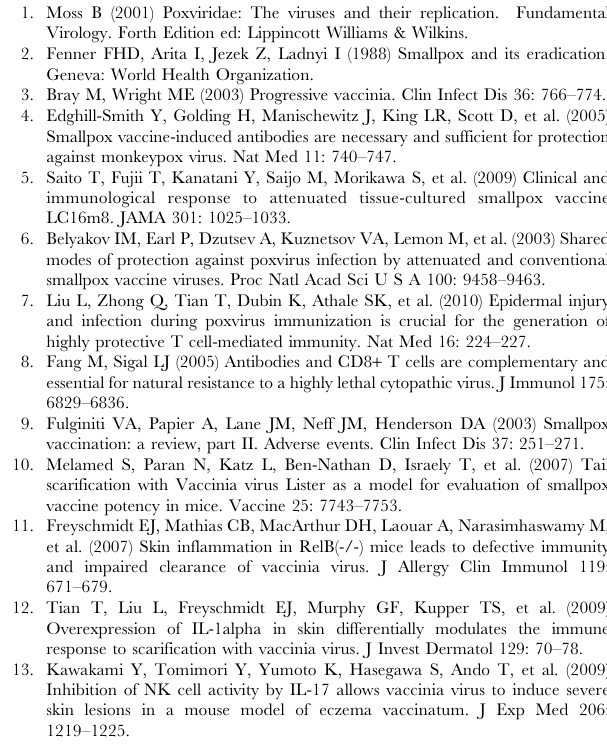
Figure S2 Lesion kinetic in Rag1 2 / 2 animals passively transferred with WT T cells. Rag1 2 / 2 mice were passively transferred with 5 6 10 5 CD4 + plus 5 6 10 5 CD8 + T cells (WT T cells), or 10 6 CD4 + T cells or 10 6 CD8 + T cells from WT (C57BL/ 6) mice. All animals were infected four days later and followed until day 60 p.i. As a control, Rag1 2 / 2 received also 10 7 splenocytes of C57BL/6 (splenocytes). The inoculation site was photographed at days 0, 5, 10 and 15 p.i. The photos shown are